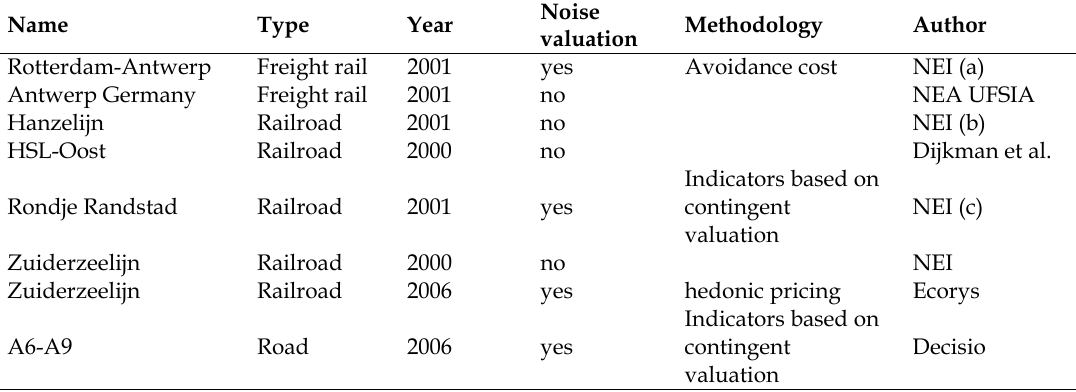
Table 1. Noise valuation in CBAs for roads and railroads, carried out in the Netherlands